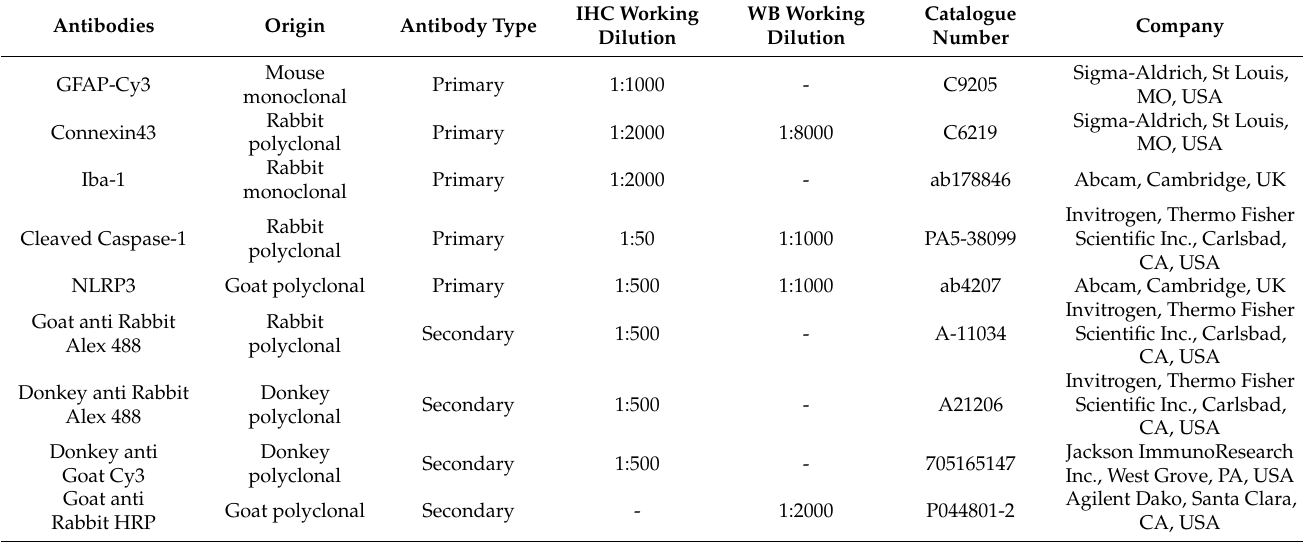
Table 1. Information on antibodies used in this